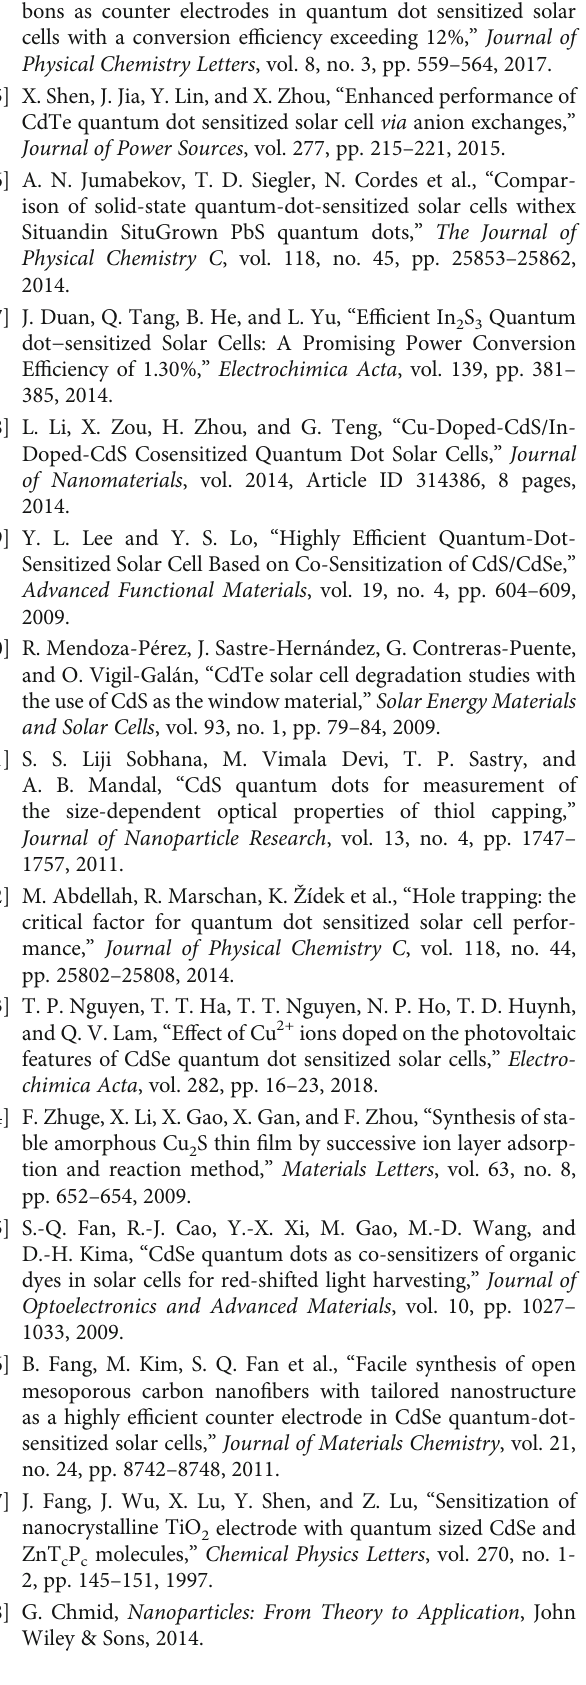
Supplemental Figure 1: (a) FESEM image, (b) Cross-section, and (c) XRD pattern of TiO /CdSe:Ag+(3%)/ZnS and (d) the 2 Raman spectrum of QDSSCs with the di ff erent